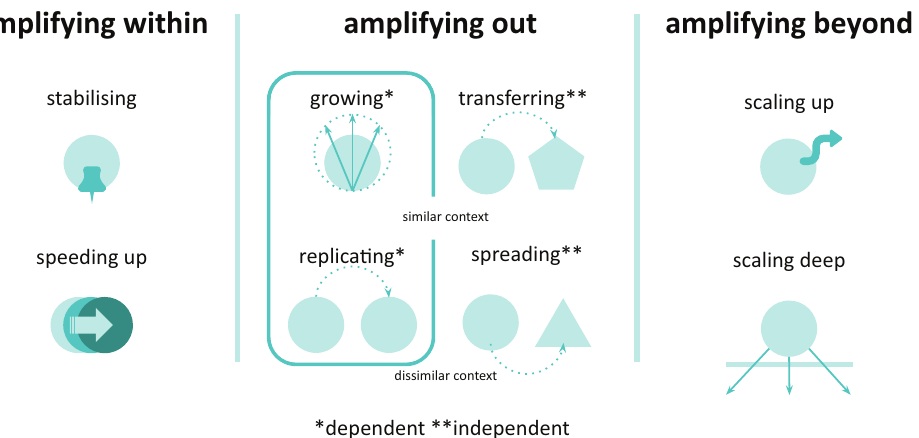
Figure 1. Typology of amplification processes based on Lam et al. (2020, p. 11). Urban Planning, 2022, Volume 7, Issue 3, Pages